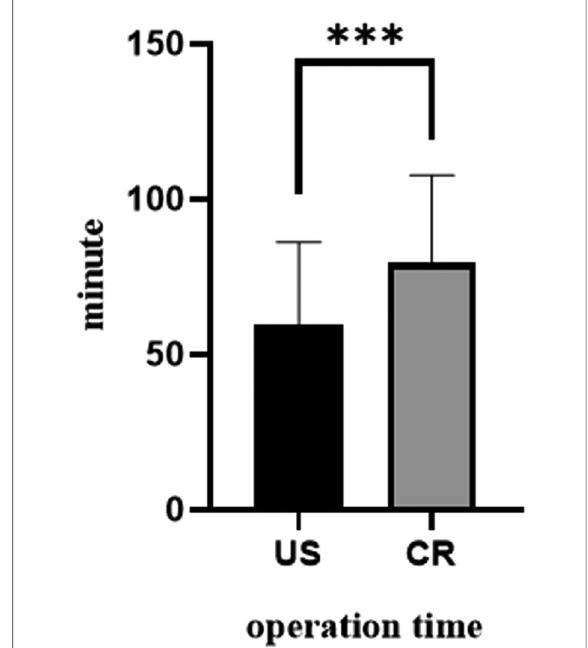
FIGURE 2 Comparison of operation time between US and CR (*** P <0.001).